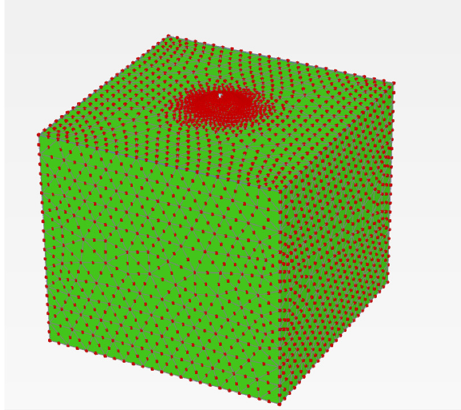
Figure 11. Generated mesh.